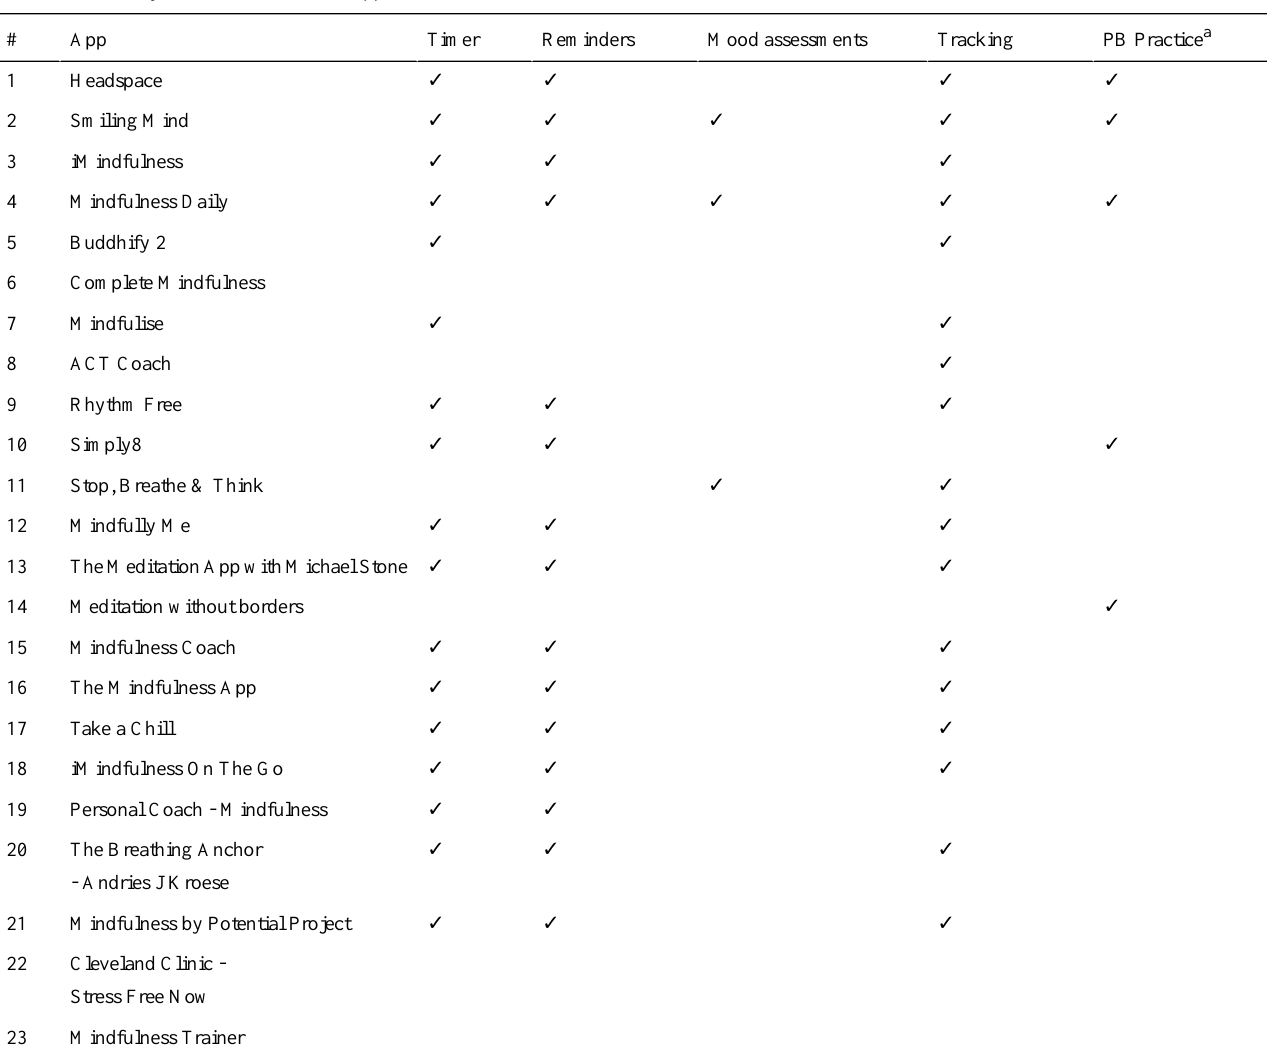
Table 2. Summary of mindfulness-based apps